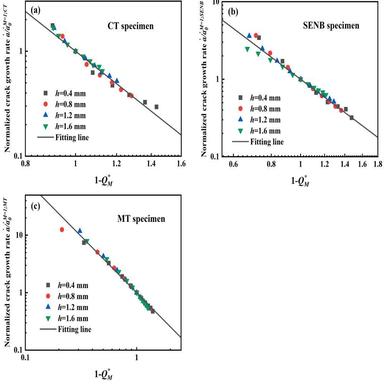
The relationship between normalized CCG rate of mismatch and (1-Q∗ M) for (a) CT, (b) SENB and (c) MT specimens.